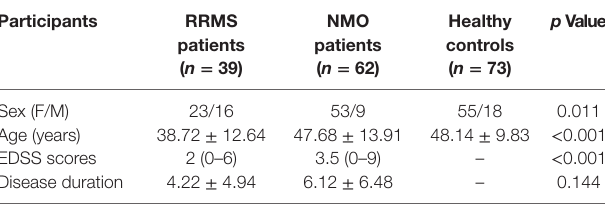
TaBle 1 | Demographic and clinical characteristics of the